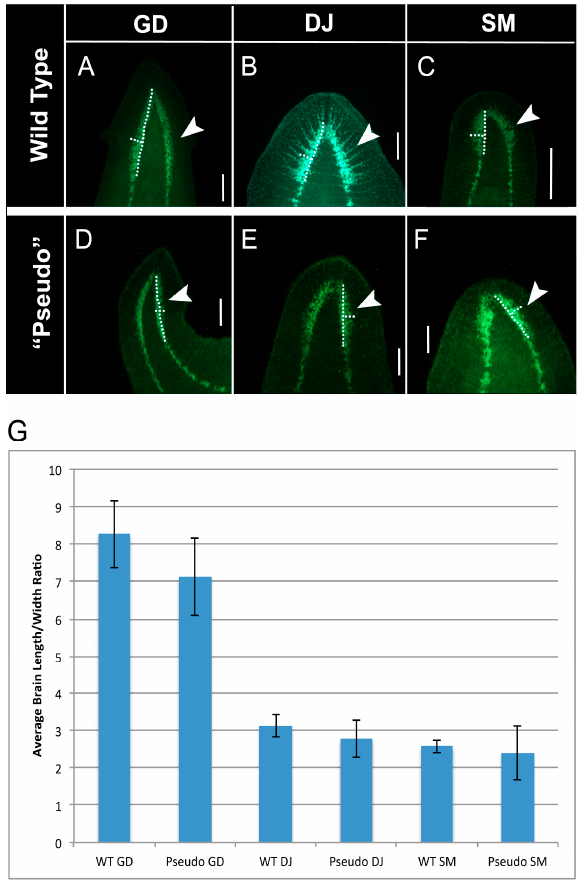
Figure 4. Brain morphology is altered after 8-OH treatment. ( A – C ) Brain morphology visualized by anti-synapsin staining of wild-type G. dorotocephala ( n = 10), D. japonica ( n = 15), and S. mediterranea ( n = 6) planarians. Arrows indicate brain morphologies, and dotted lines indicate measurements used for calculation of length/width ratio; ( D – F ) Brain morphologies by anti-synapsin staining of G. dorotocephala regenerates treated in 8-OH that resembled G. dorotocephala heads ( n = 4), D. japonica heads ( n = 4), and S. mediterranea heads ( n = 6). Arrows indicate brain morphologies, and dotted lines indicated measurements used for calculation of length/width ratio. Scale bar 0.5 mm; ( G ) Average brain length/width ratios of wild-type, and 8-OH treated worms (ANOVA p < 4.9 × 10 − 14 ). Error bars are standard deviations.